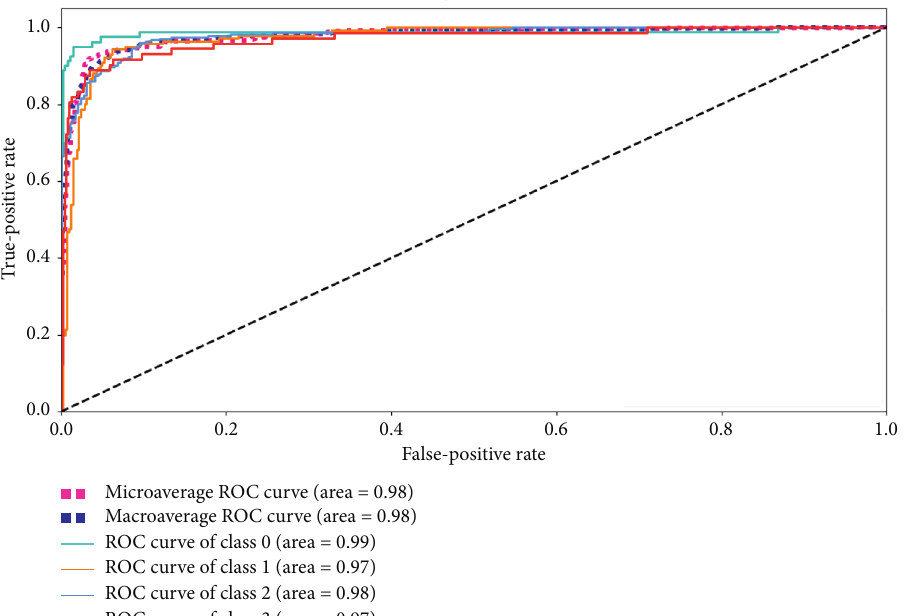
Figure 10: Area under the curve for